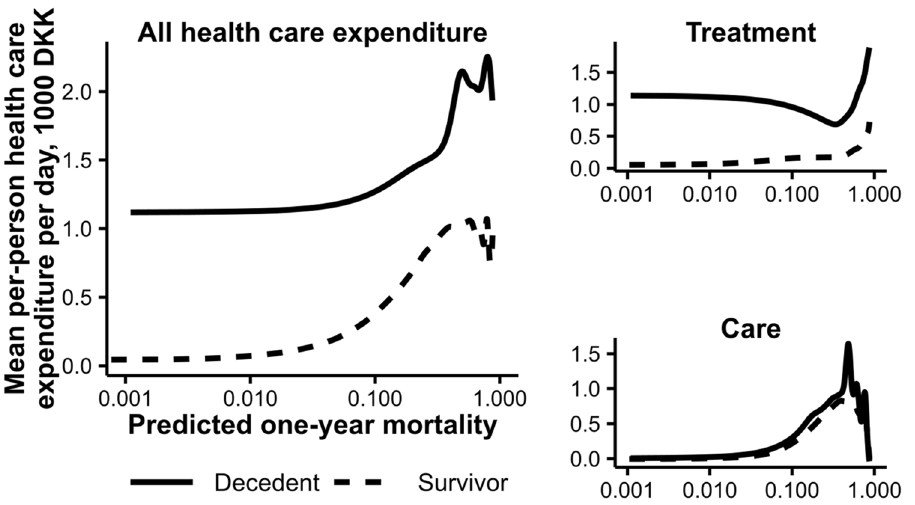
Figure 3. Kernel smoothed per-person healthcare expenditure per day by predicted one-year mortality and type of